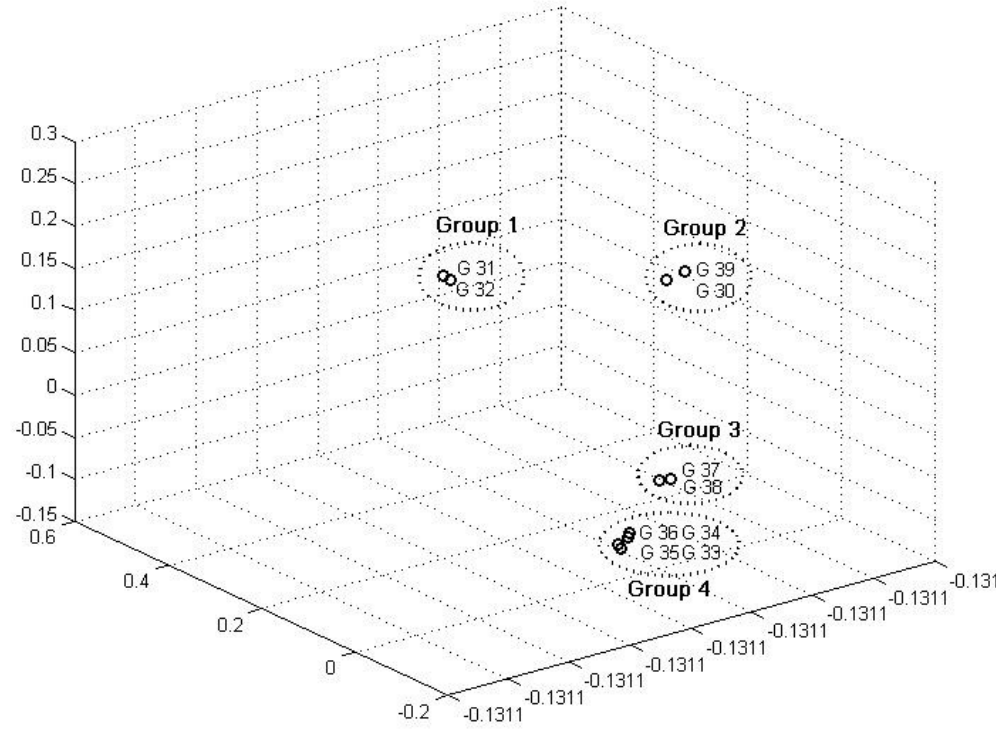
Table 2. Results obtained with the improved Laplacian eigenmap algorithm (ILEA) (39-bus